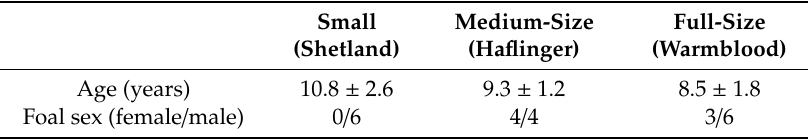
Table 1. Age of mares and sex distribution of